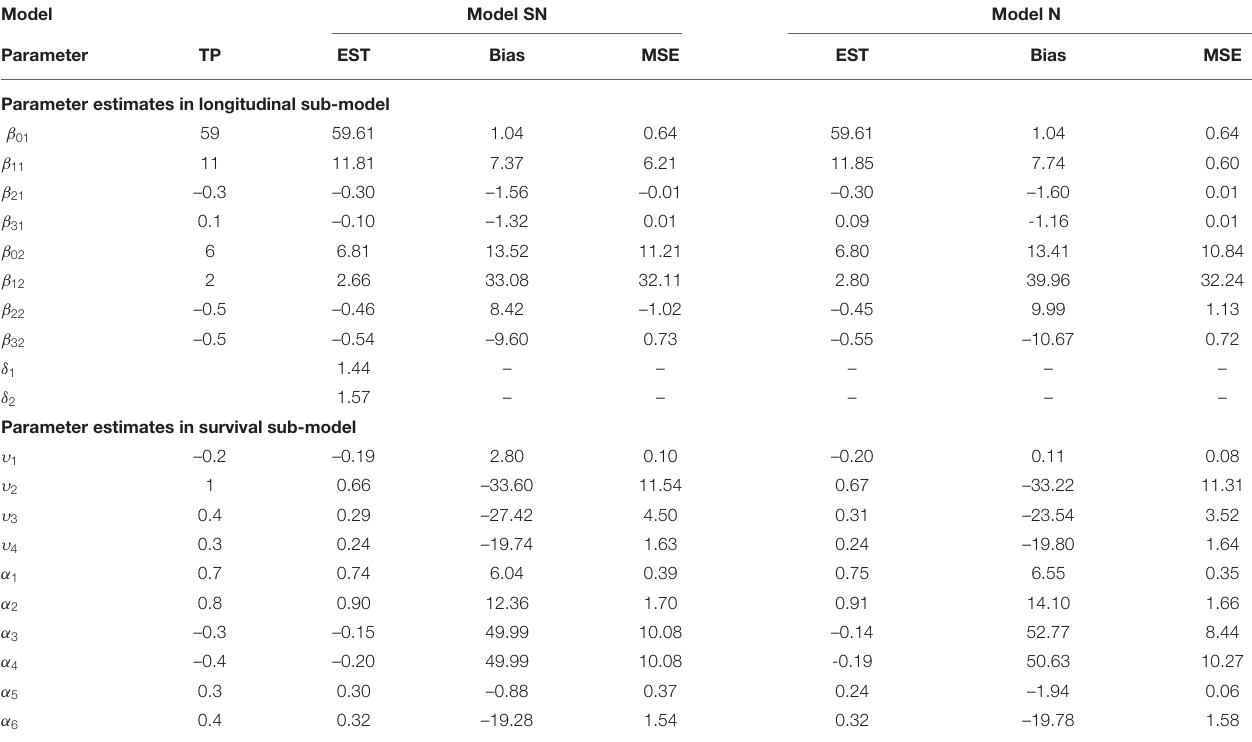
TABLE 2 | Summary of true parameter (TP) values, estimated parameters, Bias, and MSE for Models N and SN based on 50 simulated data sets. Model Model SN Model